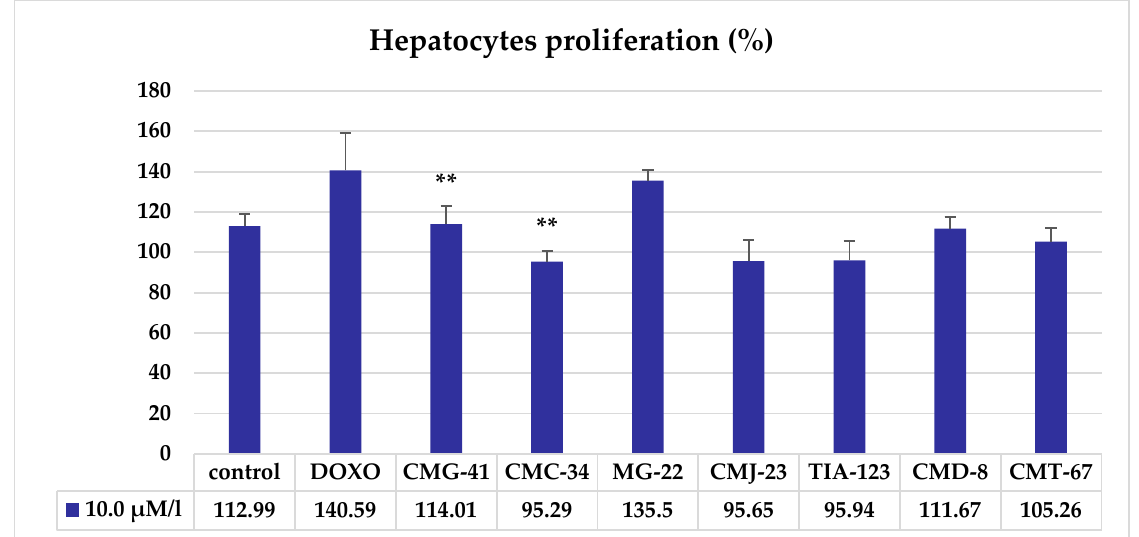
Figure 3. Proliferation of hepatocytes under the influence of thiosemicarbazide coordination com- pounds at a dose of 10.0 µ M/L assessed by the resazurin test. Note: statistical significance in comparison with the control—**— p <